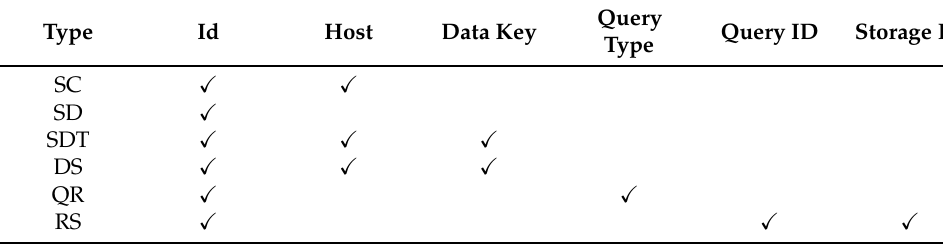
Table 3. Attributes of control messages.